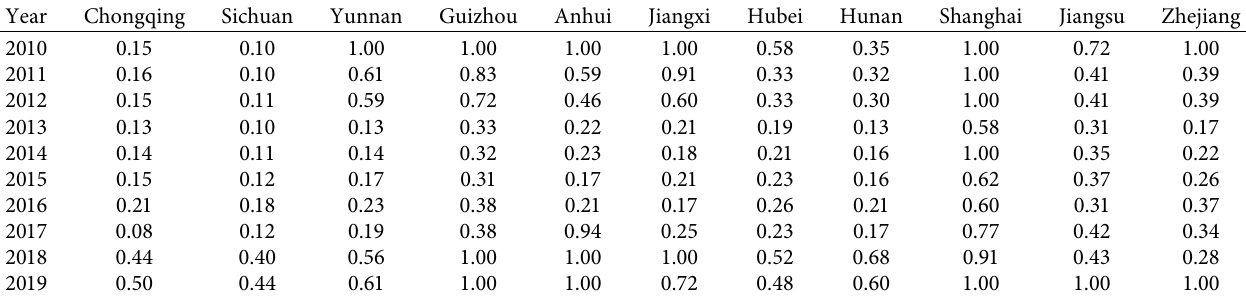
Data source: calculated according to the Chinese statistical